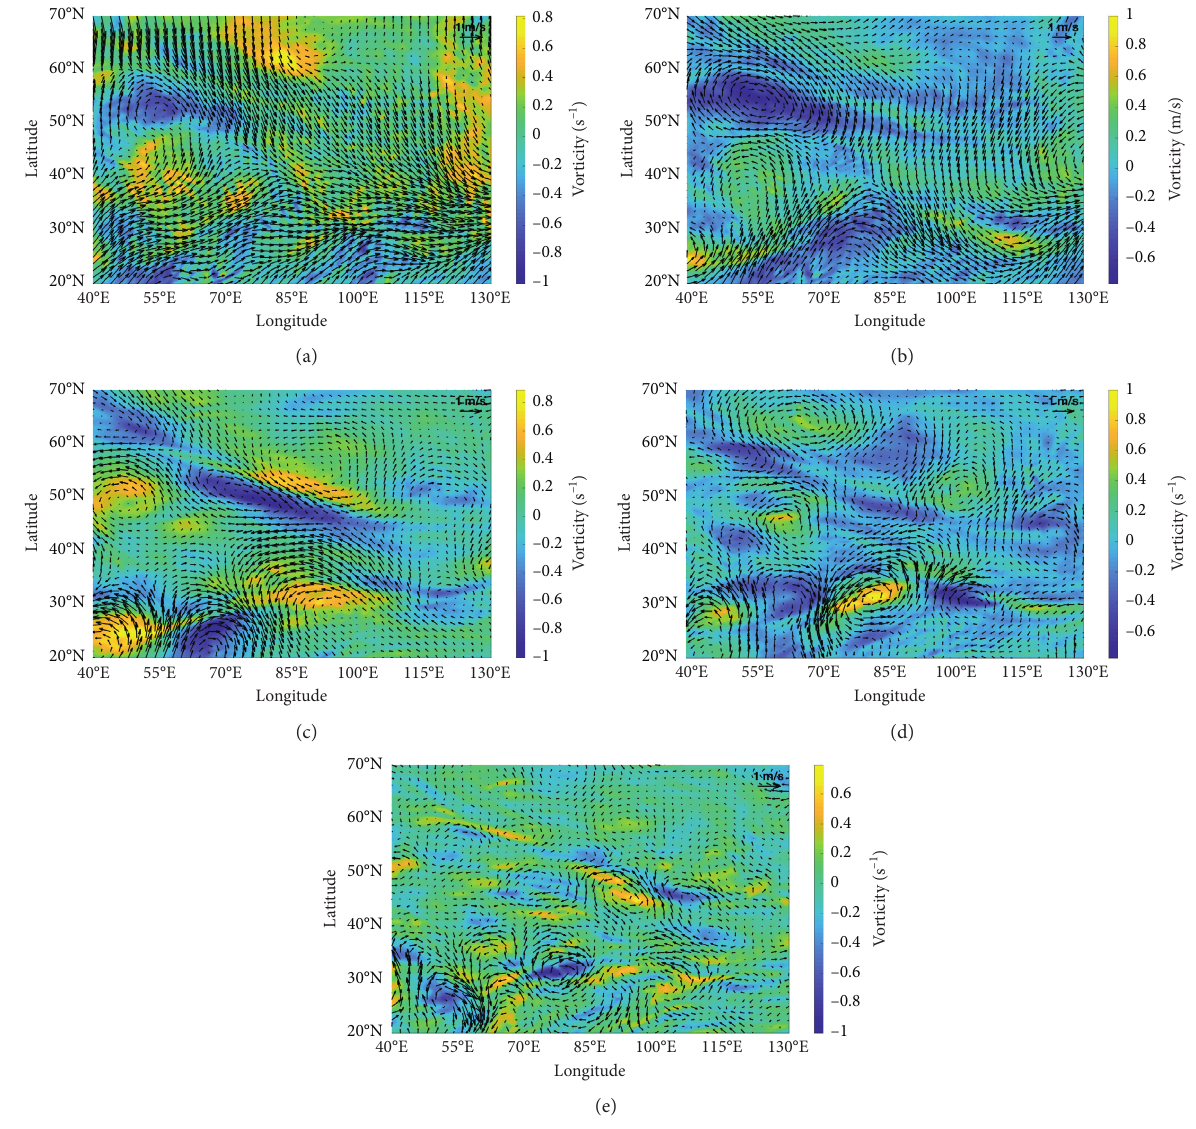
Figure 7: The five DMD modes identified by the SPDMD from the 200 hPa jet flow (a–e correspond to the 1–5th modes, velocity is visualized by vector plots, and the background color contours visualize the vertical vorticity component).